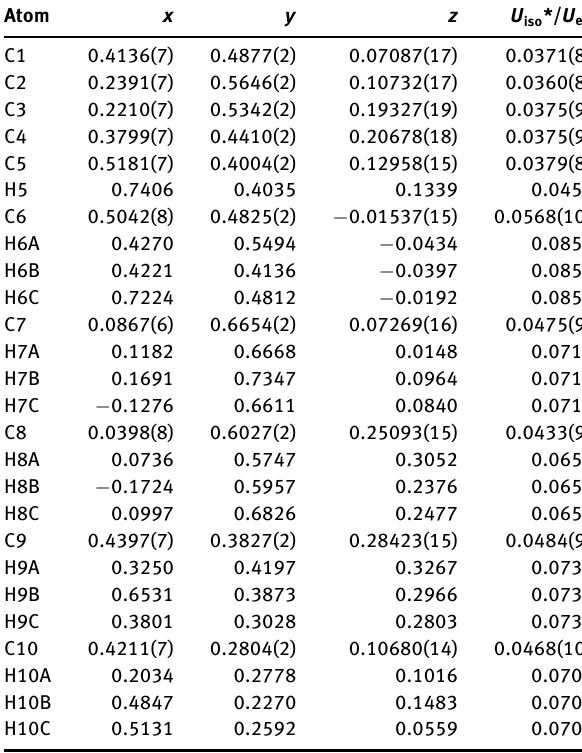
Table 2: Fractional atomic coordinates and isotropic or equivalent isotropic displacement parameters (Å 2